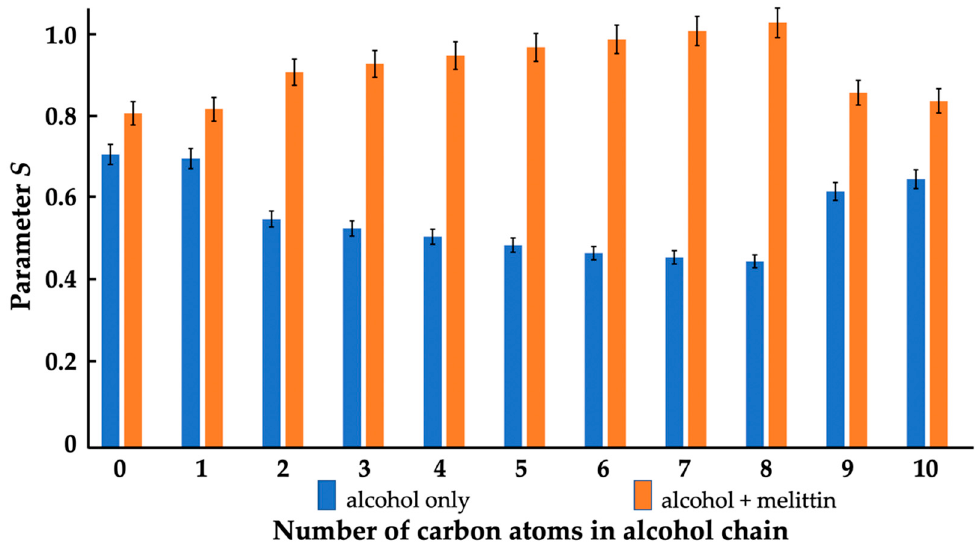
Figure 5. Effects of alcohols (5.5 × 10 − 4 M) in the absence and presence of melittin (5.5 × 10 − 5 M) on parameter S of EPR spectra of 5-DSA in oriented lipid films of phospholipid composition, mimicking that of the IMM in eukaryotes. The concentrations of total phospholipids and 5-DSA in lipid films were 5.5 × 10 − 3 M and 5.5 × 10 − 5 M, respectively. Standard deviations shown by error bars were within 5.5% of the means.